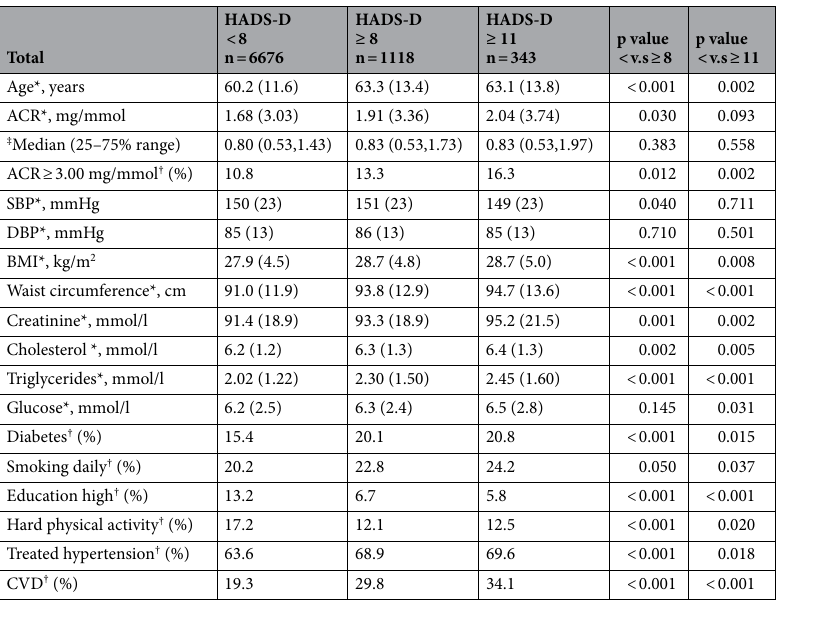
Table 1. Basic characteristics of the study population, stratified by HADS-D subgroups. Values are mean (± SD) unless otherwise stated. Independent T-test*, Mann–Whitney U statistics † or Chi-square test ‡ are used in examine differences. ACR albumin/creatinine ratio, CVD cardiovascular